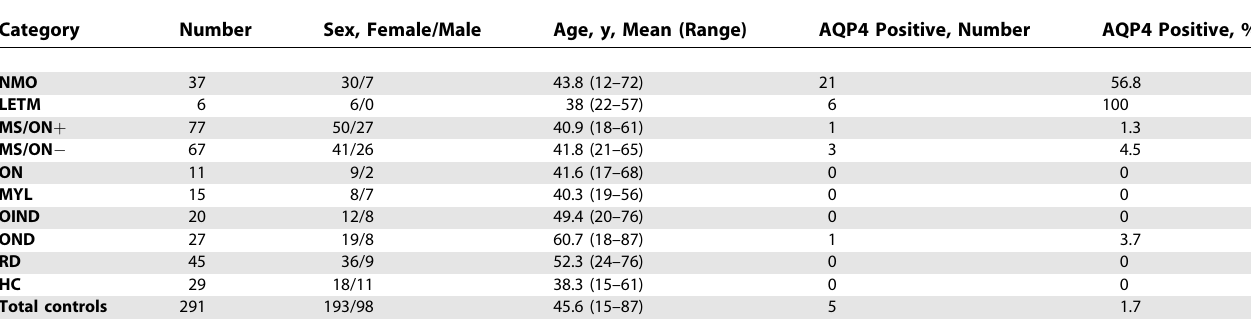
Table 1. Study Population and Proportion of AQP4-Positive Individuals in Ten Diagnostic Categories